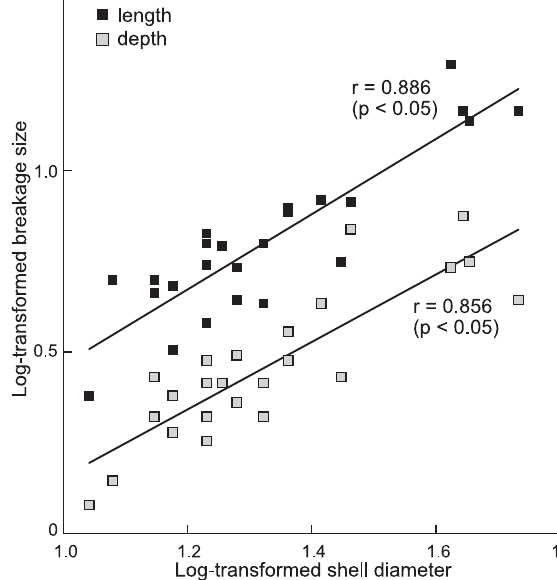
Fig. 8. Double logarithmic plots of breakage length and depth versus shell diameter. Regression lines with reduced major axis method. All seven gen- era were